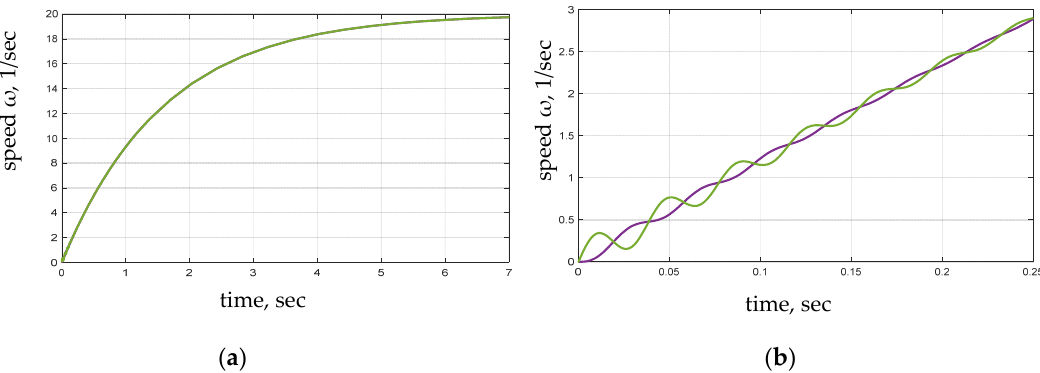
Figure 5. Dependences of speed change in the first (green) and second (purple) masses during acceleration for γ = 2: ( a ) acceleration to the desired value; ( b ) the beginning of the acceleration.